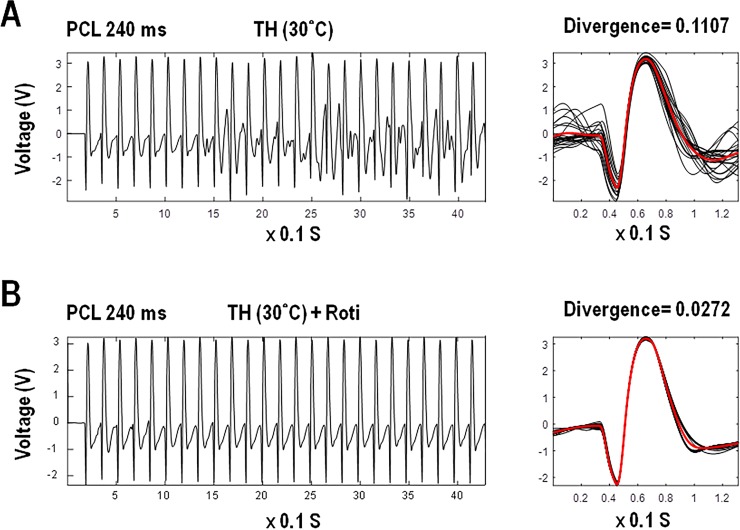
Two examples of divergence analysis at burst ventricular pacing cycle length (PCL) of 240 ms during therapeutic hypothermia (TH, 30°C) in heart #10.A, without rotigaptide, this episode shows significant morphological variation during pacing with a high divergence of 0.1107. VF occurred immediately after stopping pacing. B, with rotigaptide, this episode shows minimal morphological change during pacing with a low divergence of 0.0272. Normal rhythm was observed immediately after stopping pacing.